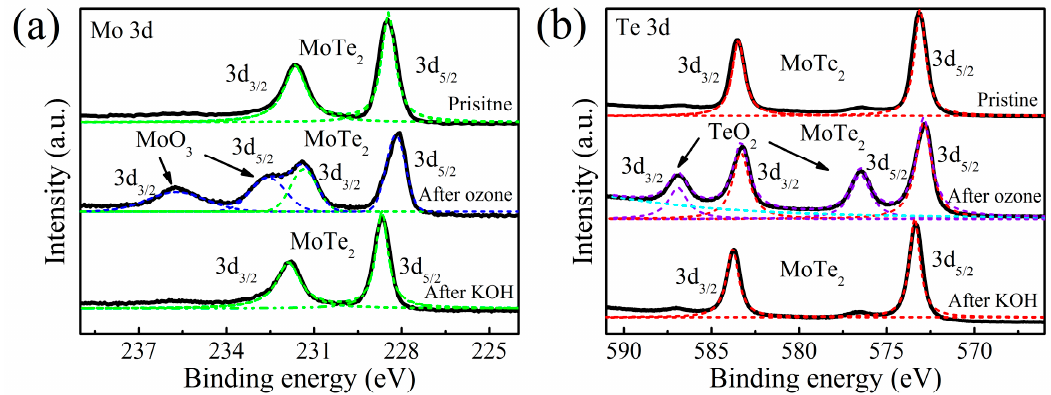
Figure 5. XPS spectra of ( a ) Mo 3d and ( b ) Te 3d core levels of MoTe 2 before / after O 3 oxidation and after KOH treatment. The black curves are experimental data. The dashed curves are the Lorentzian fits for the peaks of MoTe 2 , MoO 3 , and TeO 2 , respectively. The spectra are offset vertically for clarity.